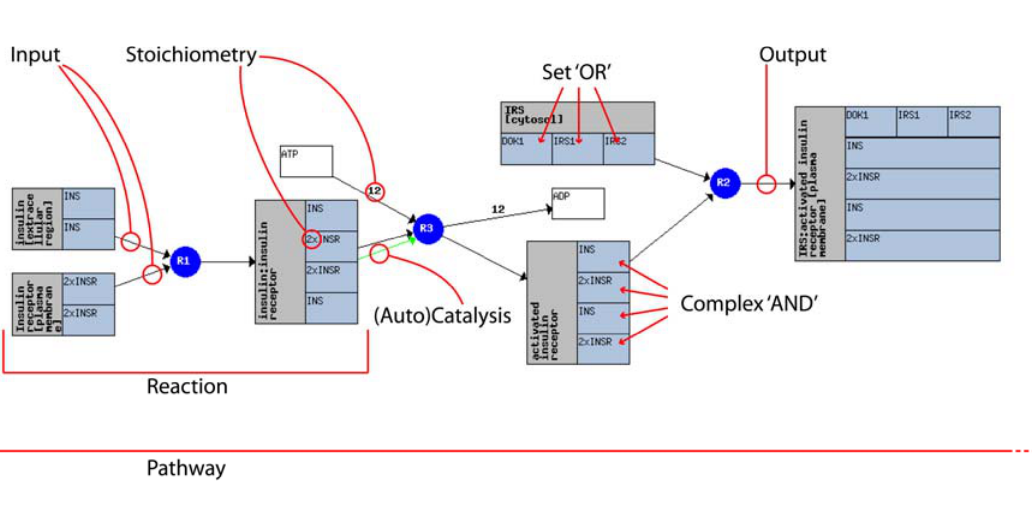
Figure 2: The interactions of five Complexes, one Set and two small molecules described over three consecutive Reactions (filled blue circles) that form part of the larger Insulin Receptor Cascade Pathway. Protein rectangles are shaded blue, small molecules are white. The reaction ‘R3’ depicts the autophosphorylation of the hormone-bound receptor. On the left hand side, note how the Insulin (INS) and Insulin Receptor (INSR) gene symbols each label two protein fragments that dimerize and tetramerize respectively to create the functional form of the proteins. The Set represents three human IRS proteins that play a role in binding the activated receptor at this stage in the